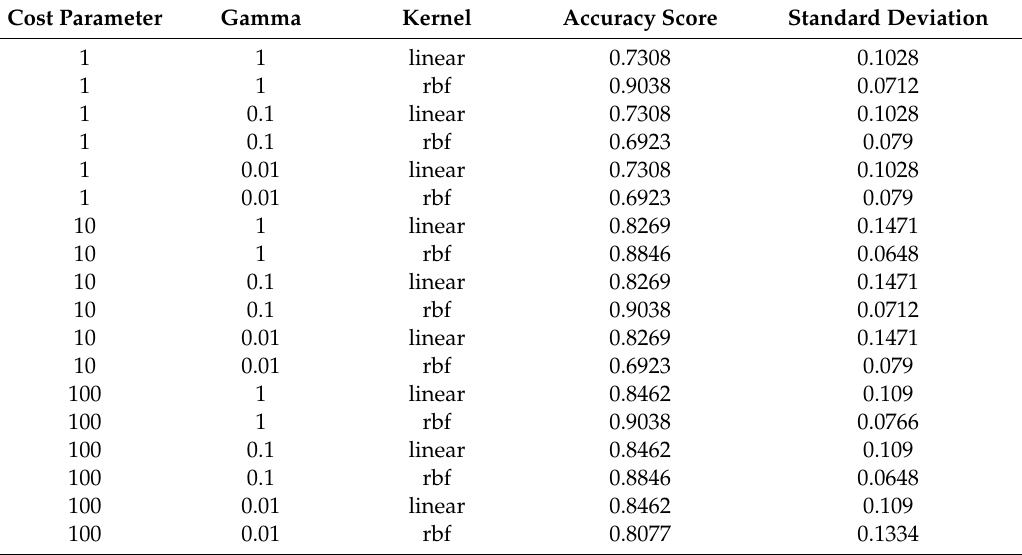
Table 4. Accuracy score and standard deviation of each feature for fruit battery